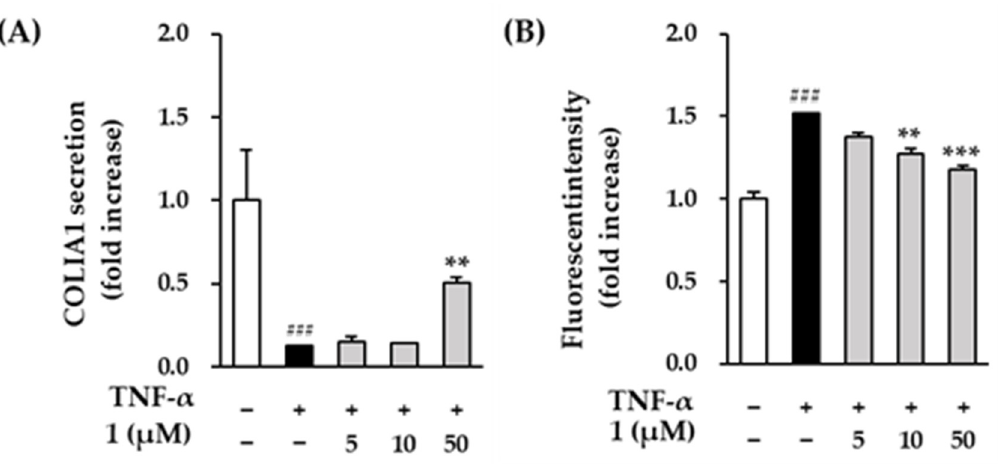
Figure 6. The effects of compound 1 on COLIA1 secretion ( A ) and ROS production ( B ) in TNF- α treated HDFs. ( A ) The cells were seeded on 48-well plate with the density of 2 × 10 4 cells/well and starved with non-serum media for 24 h. Next, before being exposed to 20 ng/mL TNF- α for 24 h, the cells were first given the relevant sample concentrations to use for 1 h. The COLIA1 secretion in supernatants were determined using ELISA kit. ( B ) The cells were seeded on 96-well plate with the density of 1 × 10 4 cells/well and starved with non-serum media for 24 h. Next, the cells were treated with indicated concentration of samples for 1 h before exposure to 20 ng/mL TNF- α and 10 µ M DCFDA. MMP-1 and COLIA1 mRNA was assessed using qRT-PCR analysis. The data were described as mean ± SEM. ### p < 0.001 non-treatment group versus TNF- α treatment group. ** p < 0.01 and *** p < 0.001 sample treatment group versus TNF- α treatment